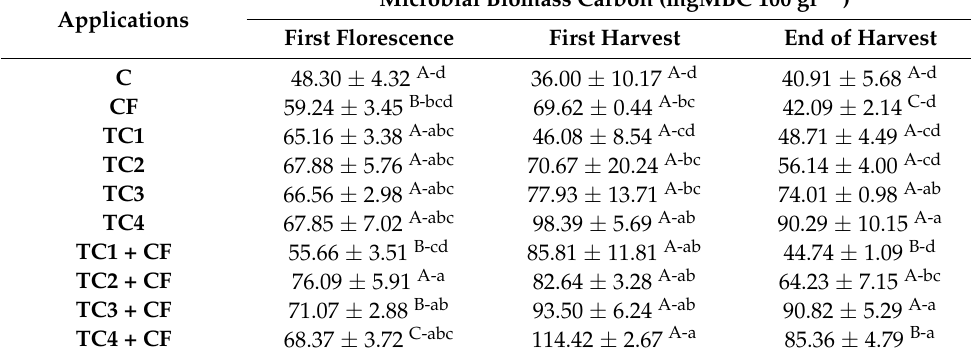
Table 5. MBC production